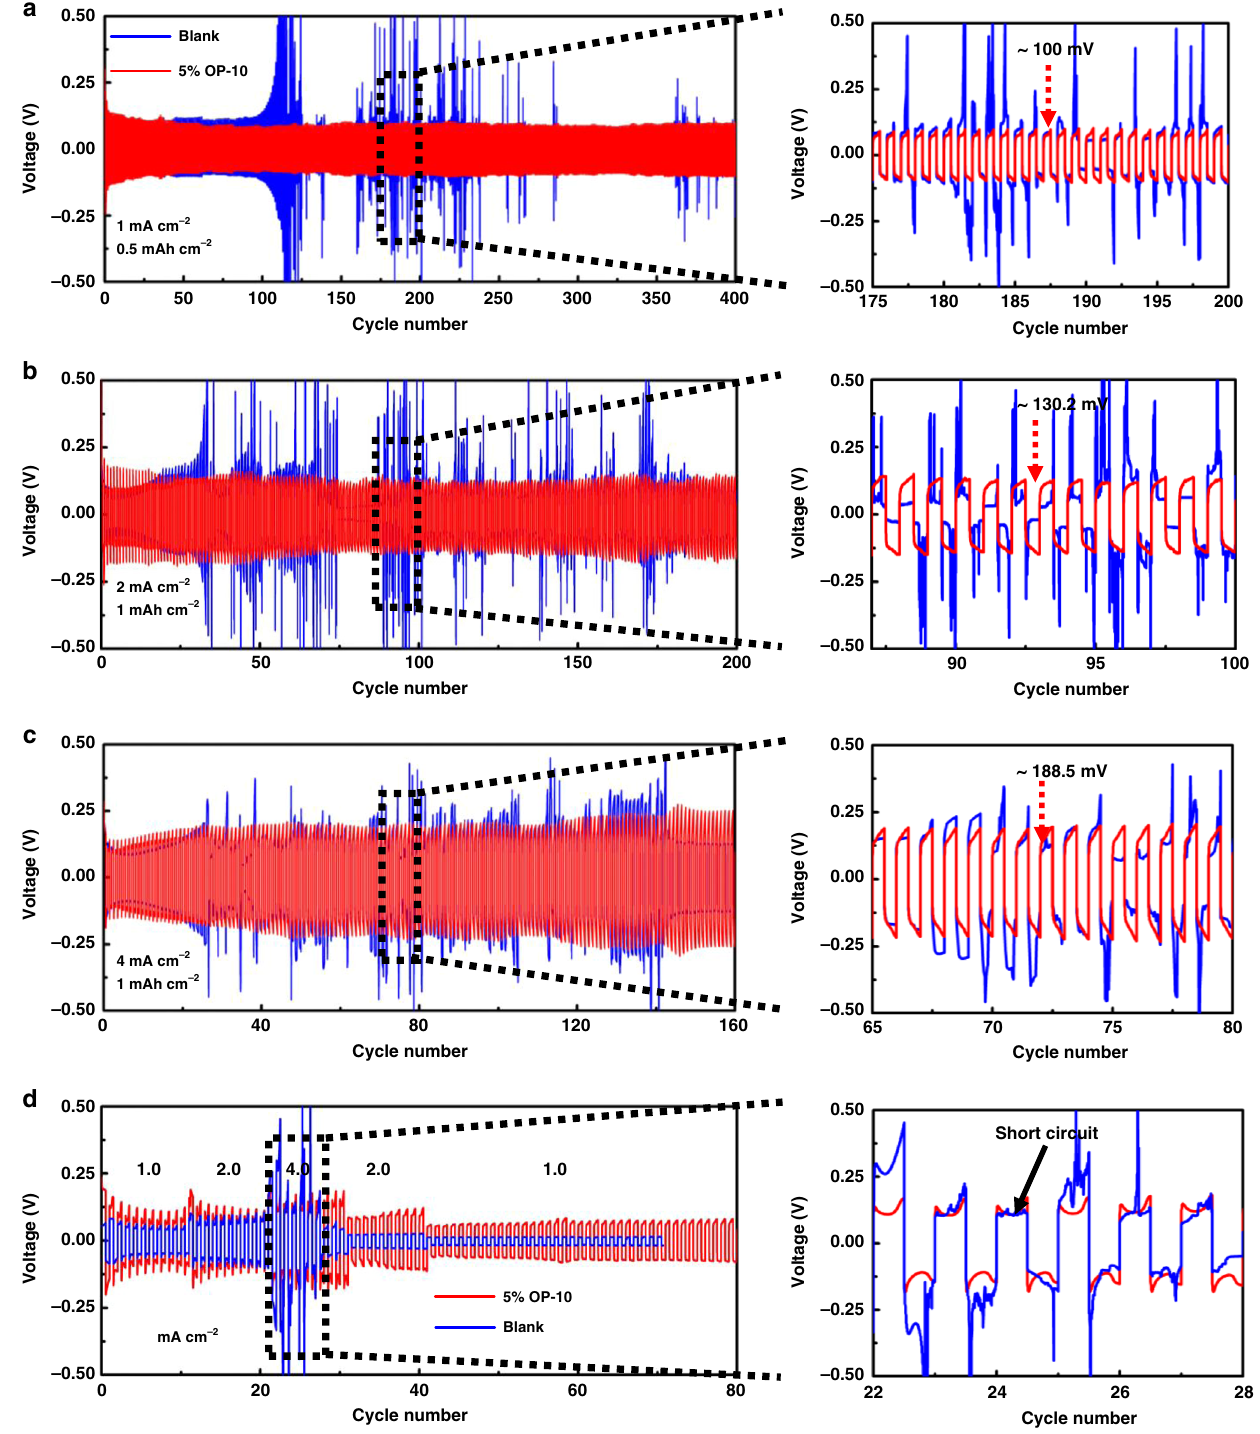
Fig. 3 Electrochemical performance of symmetric Li|Li cells without additives (blue) and with added OP-10 (red). Cells were cycled at a current density of 1 mA cm − 2 and a fi xed capacity of 0.5 mAh cm − 2 ( a ), a current density of 2 mA cm − 2 and a fi xed capacity of 1 mAh cm − 2 ( b ), and a current density of 4 mA cm − 2 and a fi xed capacity of 1 mAh cm − 2 ( c ). Rate performance of modi fi ed and unmodi fi ed electrolytes tested at current densities of 1, 2, and 4 mA cm − 2 after 0.5 h each of Li plating and stripping ( d